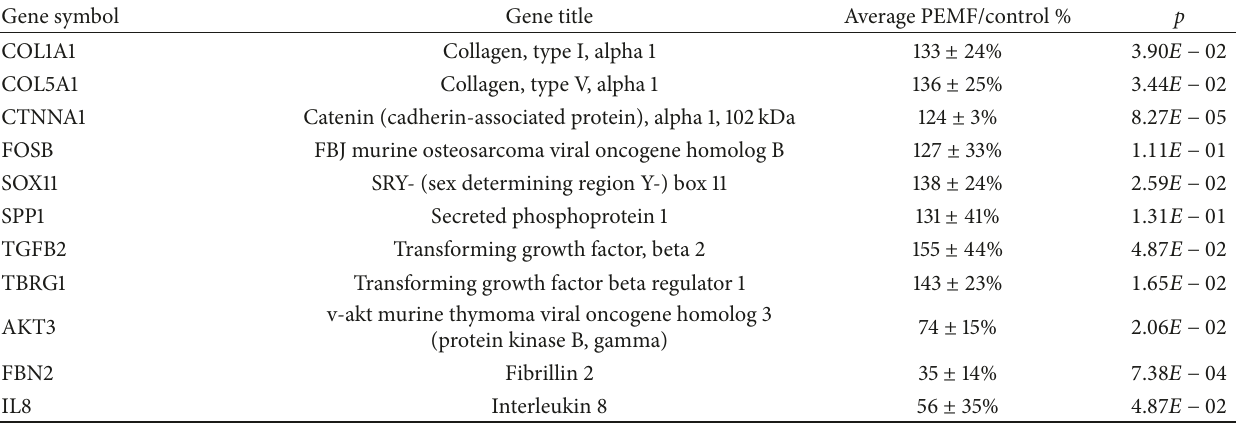
Table 5: Real-time RT-PCR of three different female donor samples’ hBMSCs, aged 24, 27, and 31 years in the differentiation stage. Analysis by Student’s t-